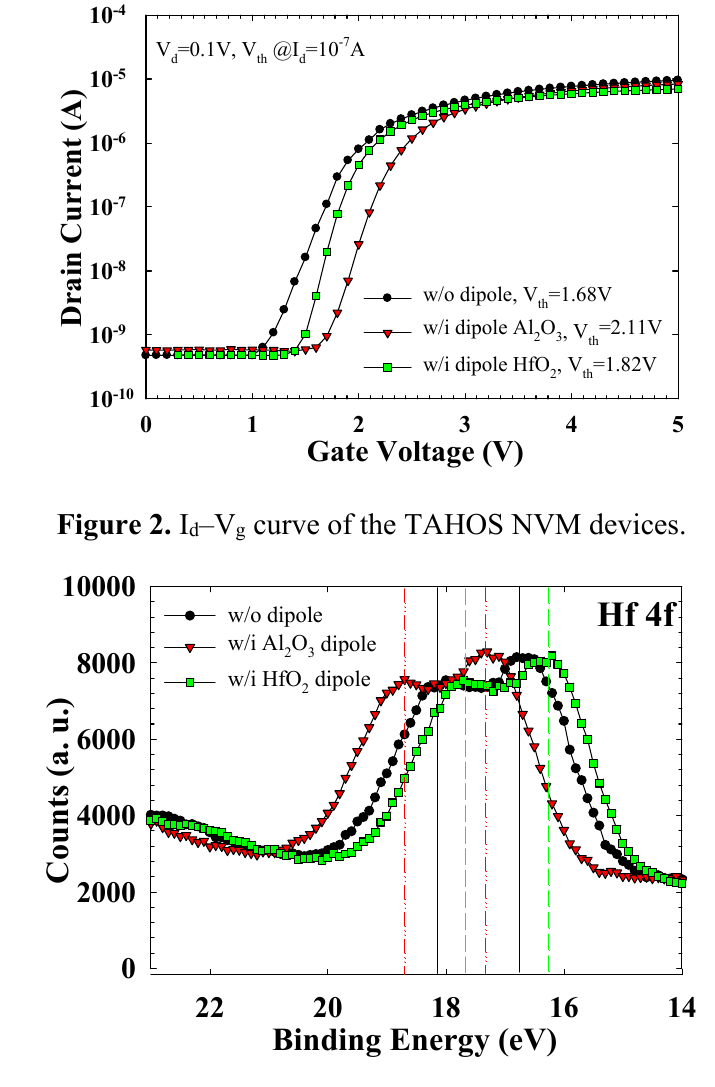
Figure 3. Hf 4f XPS spectra of the samples without dipole, with Al 2 O 3 dipole, and with HfO 2